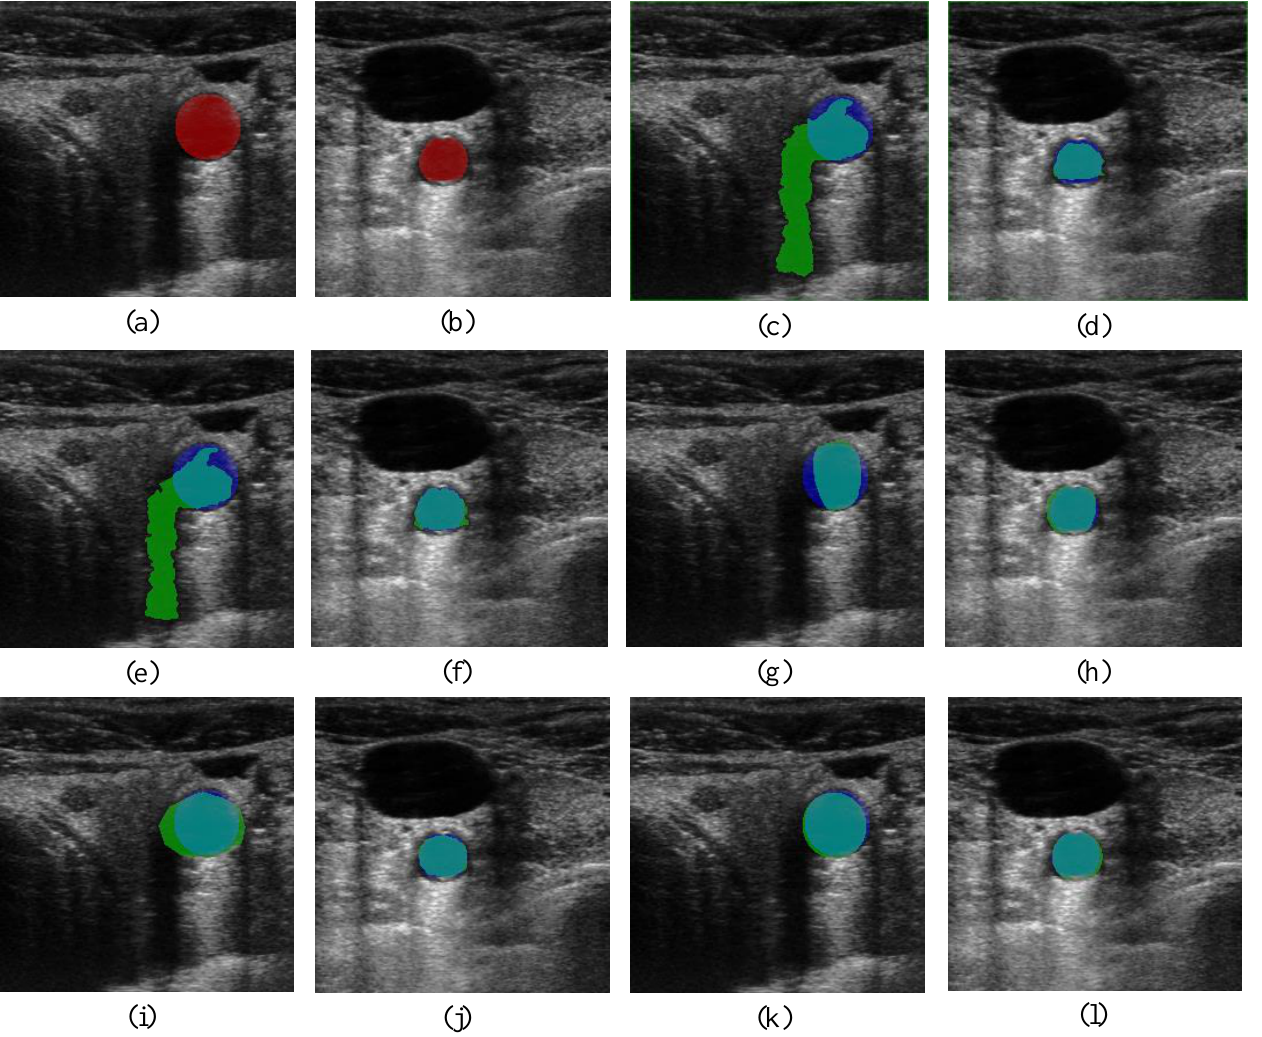
Figure 12. ( a , b ) Original US images with the ground truth marked in red; ( c , d ) fuzzy C-mean; ( e , f ) active contour model; ( g , h ) parametric snake; ( i , j ) active shape model; ( k , l ) proposed method. Please see the main text for the meaning of each